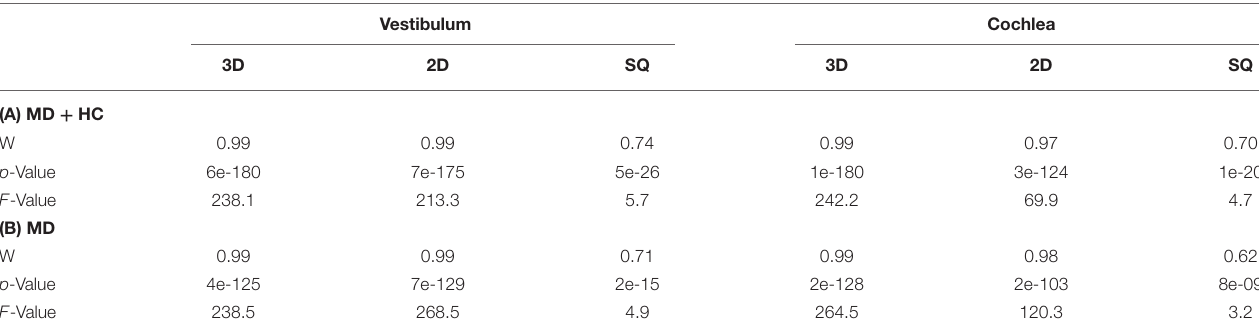
TABLE 4 | Interrelations between ELS quantification